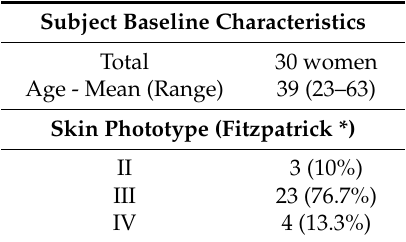
Table 1. Baseline characteristics of subjects.